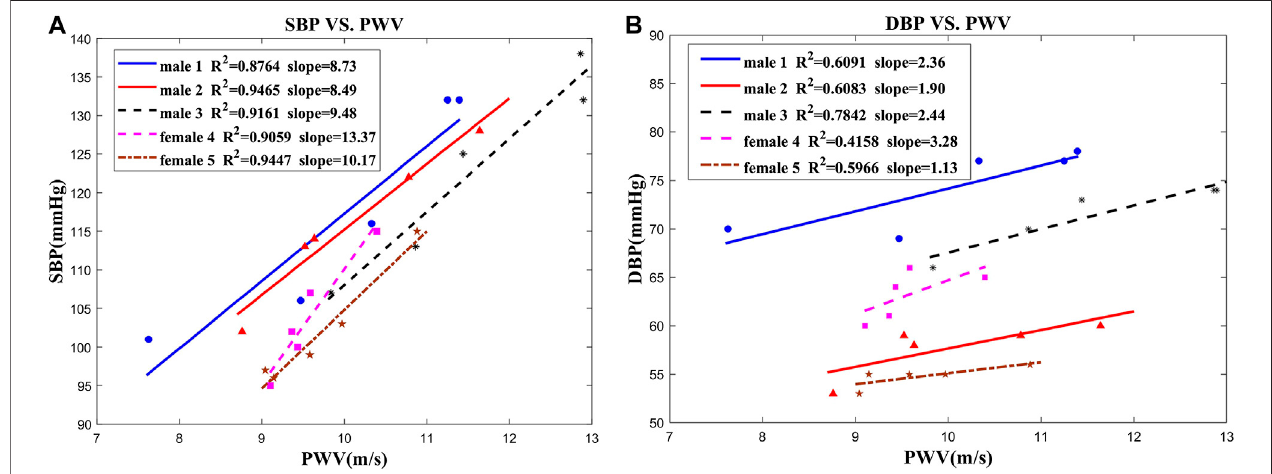
FIGURE 6 | Correlation between blood pressure and PWV in fi ve subjects: (A) SBP vs. PWV; (B) DBP vs.